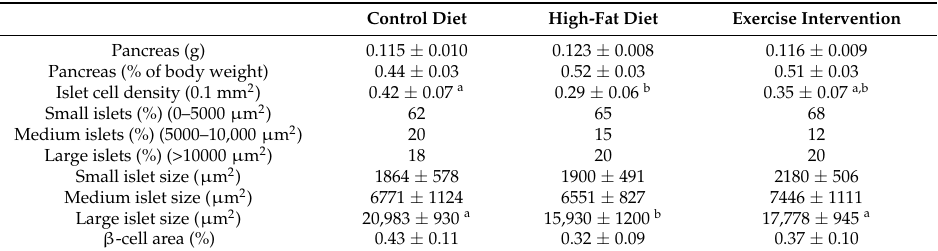
Table 3. Effect of founder high fat diet with exercise interventions on male offspring pancreas morphology at 8 weeks.